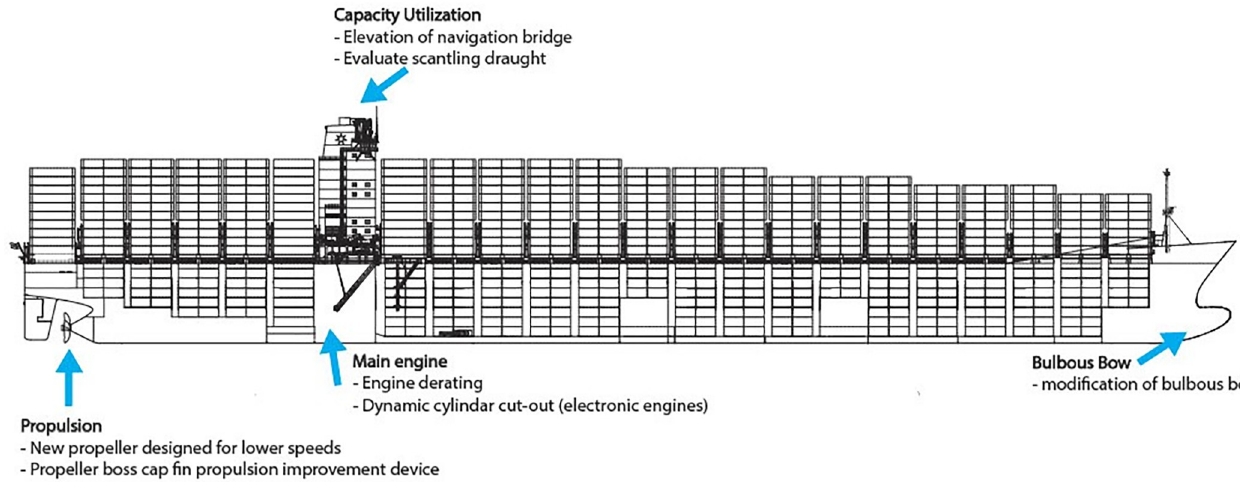
Fig 1. G-Class vessel post-retrofit. G-Class vessel post-retrofit, modified from the original blueprint provided by Maersk. Changes from pre- to post- retrofitting are identified with